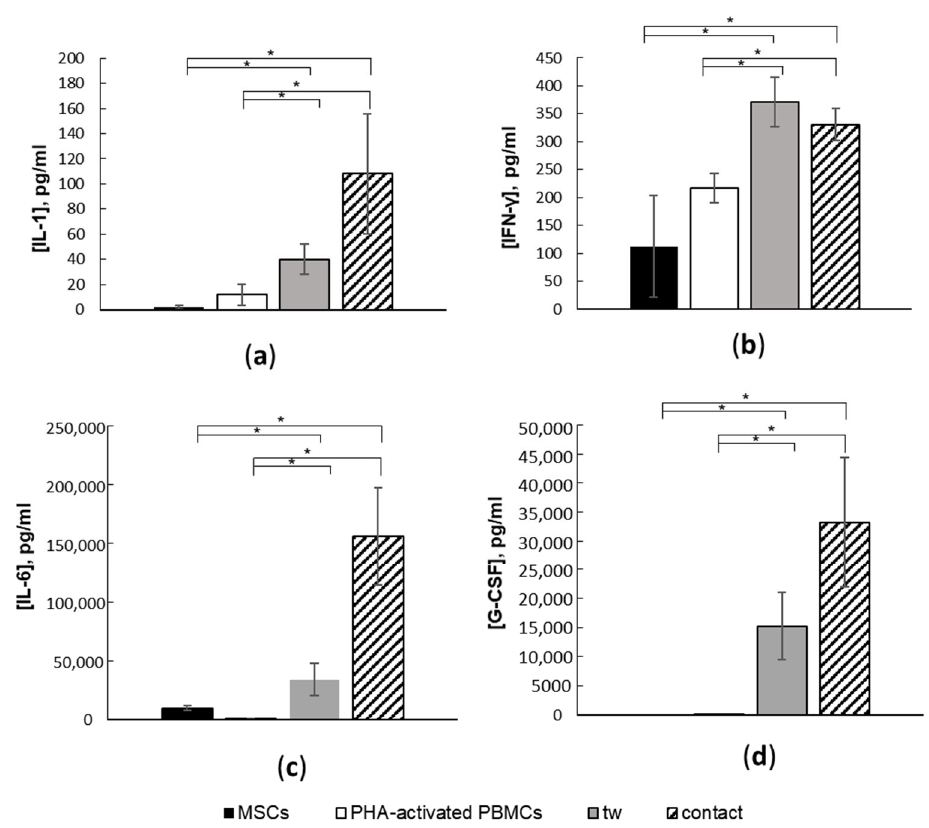
Figure 6. Suppression of PBMC proliferation in the presence of MSCs accompanied